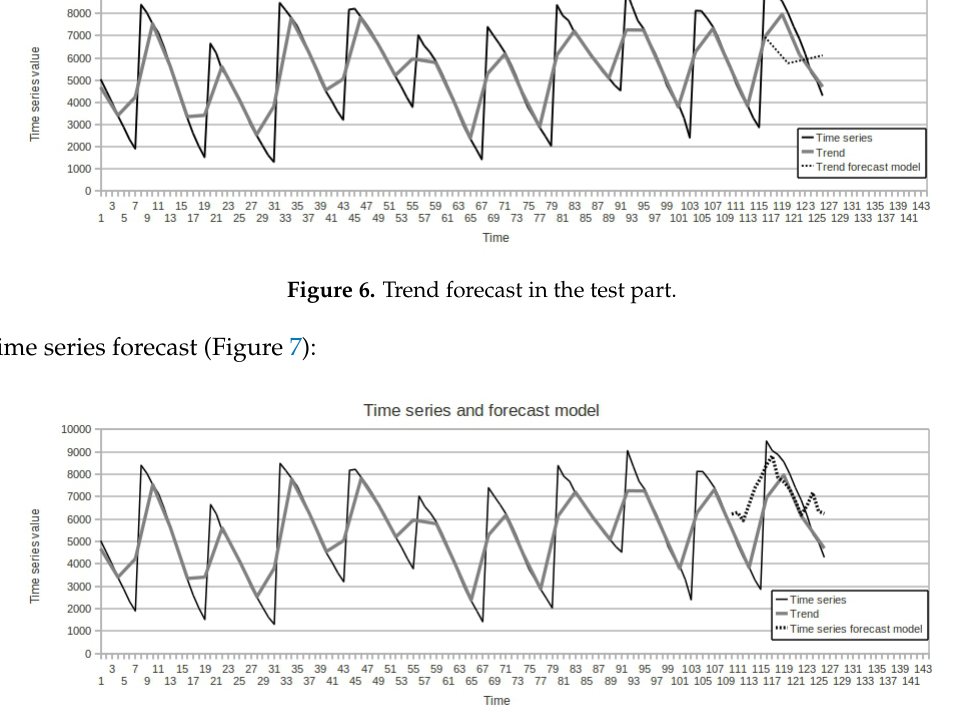
Figure 7. Time series forecast in the test part.